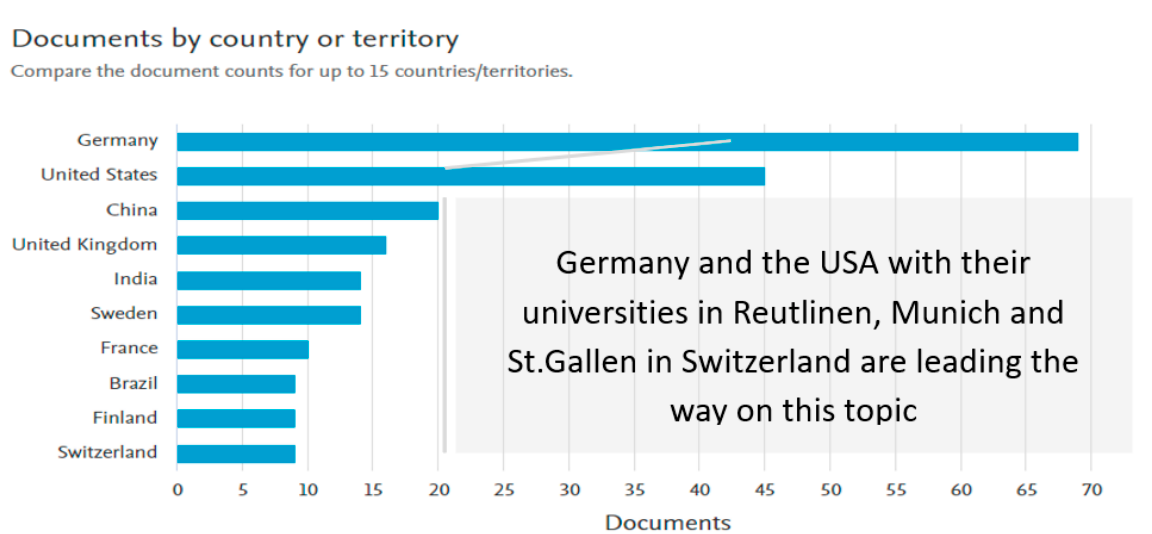
Figure 4. Agile AND transformation AND manufacturing—Documents by Subject area.